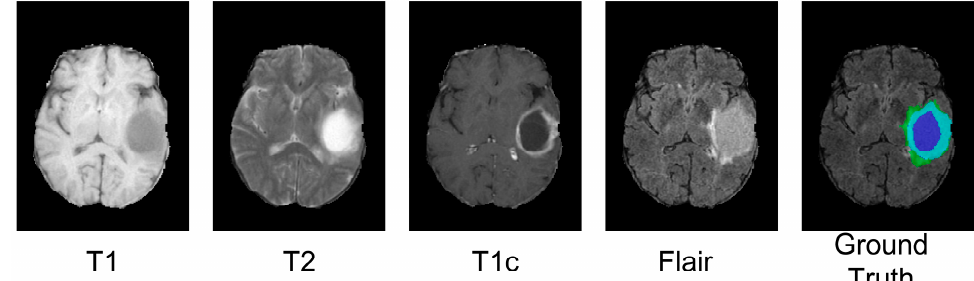
Figure 1. A visualized case is chosen from the BraTS2021 training dataset. (Different colors present different tumor types. Whole Tumors (WTs) are shown in blue, purple, and green, Tumor Cores (TCs) are shown in blue and purple and Enhanced Tumors (ETs) are shown in blue.)